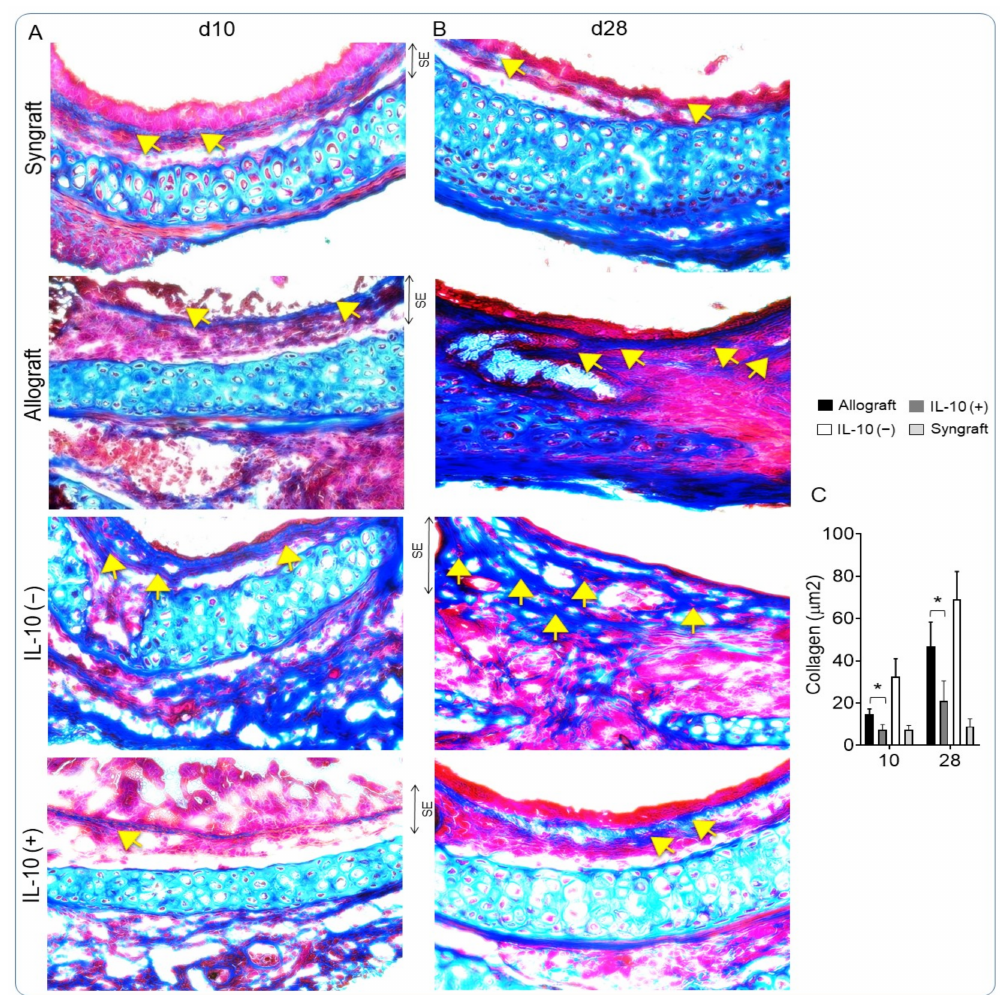
Figure 6. IL-10 is sufficient to suppress subepithelial fibrosis. ( A , B ) Collagen staining of graft transverse sections and ( C ) Semiquantitative analysis of subepithelial deposition of collagen in control and IL-10-treated allografts at d10 and d28 post-transplantation: Blue bands represent subepithelial collagen deposition, and semi-quantitative analysis of blue collagen bands was performed using the ImageJ program. ‘SE’ designates subepithelial areas in the graft section. Data are shown as means with SE 16 transplants/time point/experiment. * p < 0.05. Original magnification, ×